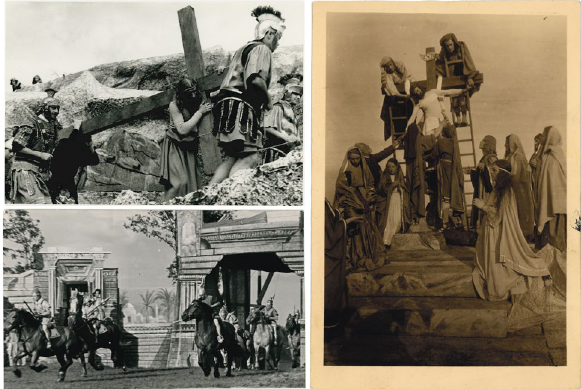
Figure 5 . Collage with some historical pictures. © Archive of